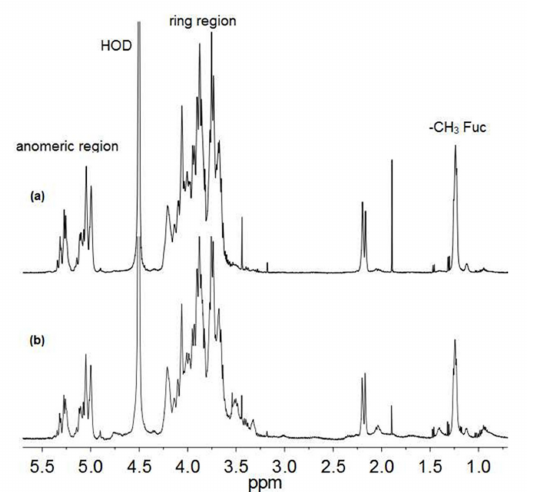
Figure 2. 1 H NMR spectra of PLS-B ( a ) and PLS-C ( b ) samples obtained from T. versicolor culture filtrate after size exclusion chromatography (SEC) separation. Spectra were recorded at 50 ◦ C on a 500 MHz spectrometer. Main resonances are